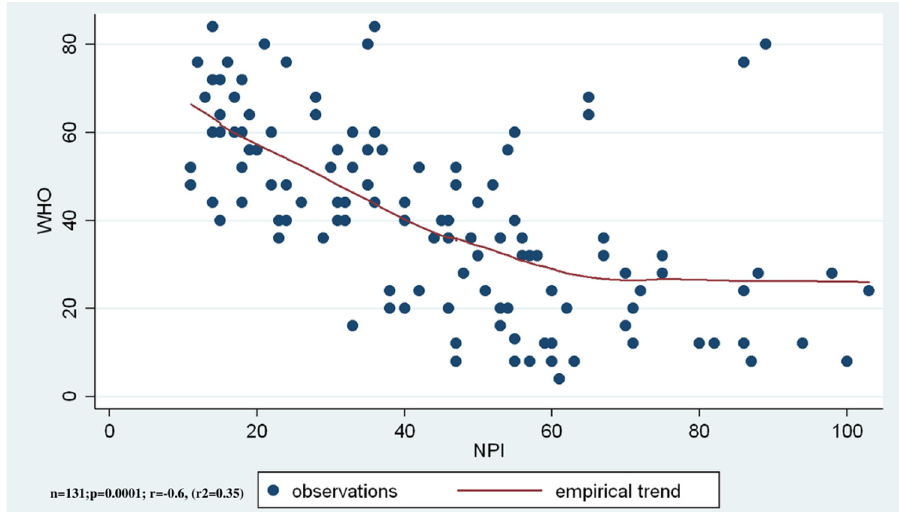
Figure 2: The quality of life is signi fi cantly negatively correlated to the NPSs ’ total